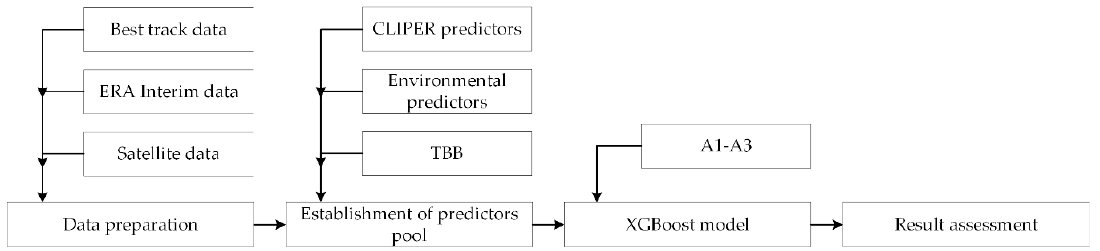
Figure 1. Flowchart of proposed TC intensity prediction model.